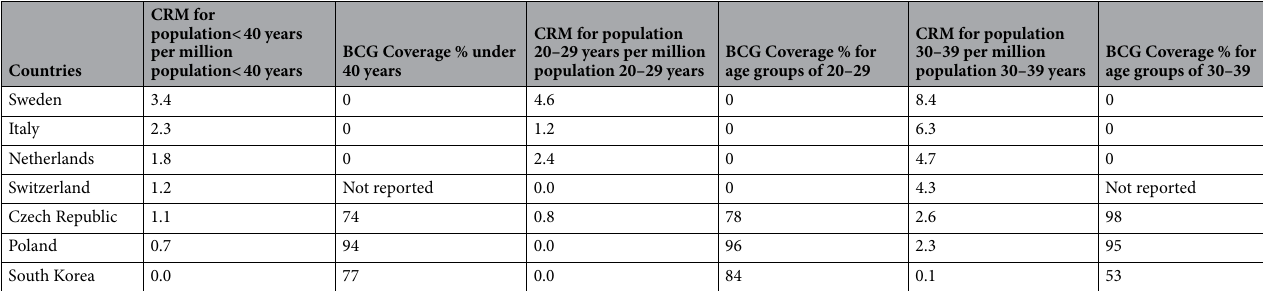
Table 3. Analysis of CRM for populations aged < 40 compared with the percent BCG vaccination rate in the same age group. Countries with lower rates of BCG coverage generally have higher rates of CRM suggesting that, even in a less vulnerable population, BCG vaccination is associated with improved